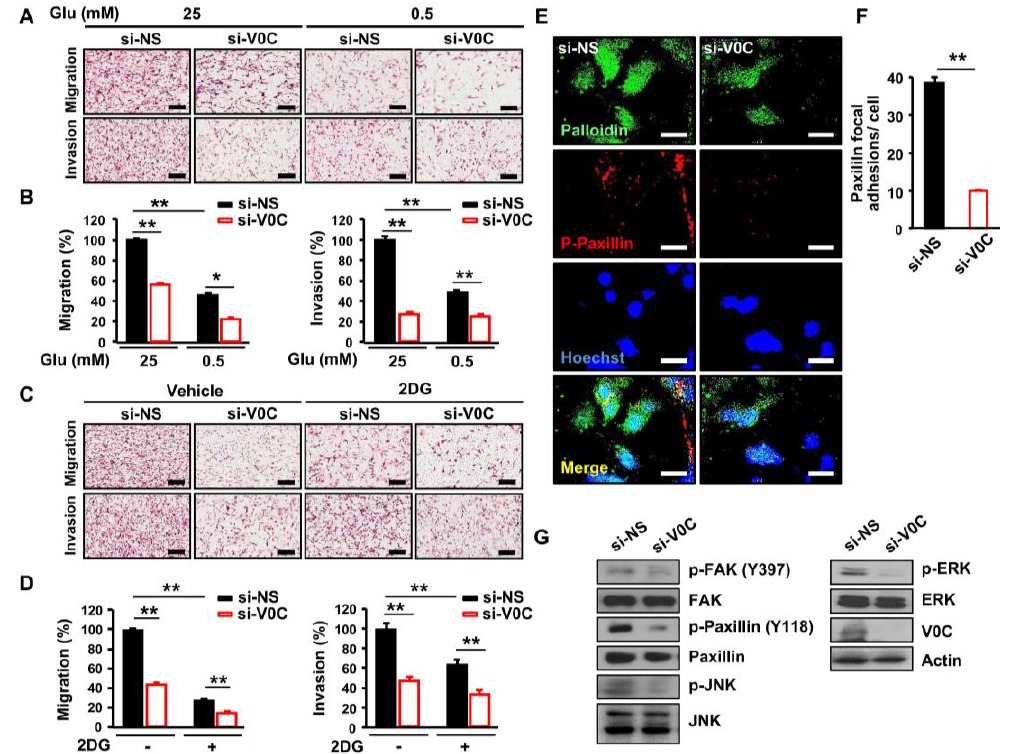
Figure 2. ATP6V0C depletion attenuates migration, invasion, and formation of focal adhesions in ECCs. ( A – D ) TE8 cells were transfected with NS or si-V0C. ( A , B ) Cell migration and invasion assays were performed after transfection under high- (25 mM) or low- (0.5 mM) glucose conditions. ( C , D ) Images showing migration and invasion assays in 2-deoxy-D-glucose (2DG) (5 mM) treated TE8 cells. ( A – D ) Cells were fixed and stained with H&E, and the slides of filters of migrated or invaded cells were scanned using an Aperio scanner (original magnification 100 × ). Scale bars = 400 µ m. ( E ) TE8 cells were immunostained with p-paxillin antibody and rhodamine-labeled secondary antibody, Hoechst, and Alexa 488 phalloidin, and then viewed by fluorescence microscopy. Scale bars = 50 µ m. ( F ) The numbers of paxillin focal adhesions per cell were determined. ( G ) TE8 cell lysates were analyzed by immunoblotting with the indicated antibodies. Assays and blots are representative of two independent experiments. Values are mean ± SEM. (ANOVA; * p < 0.05, ** p < 0.01).